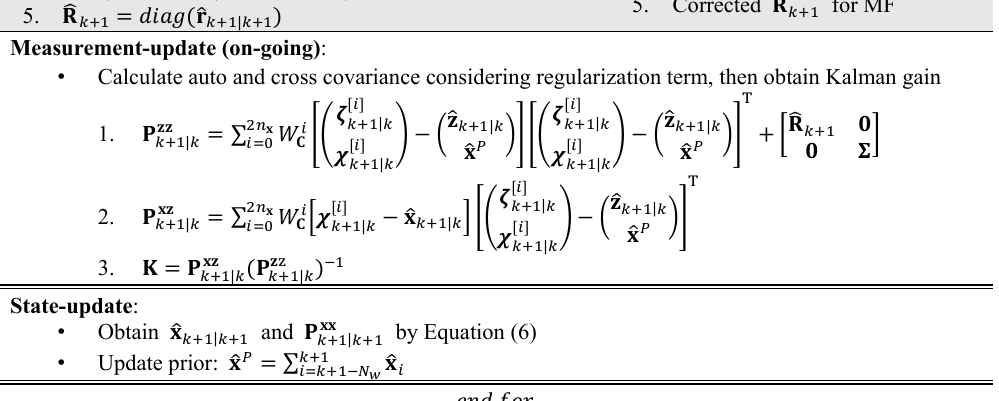
Figure 3. Algorithm of Master-Slave Kalman Filter for noise measurement estimation.